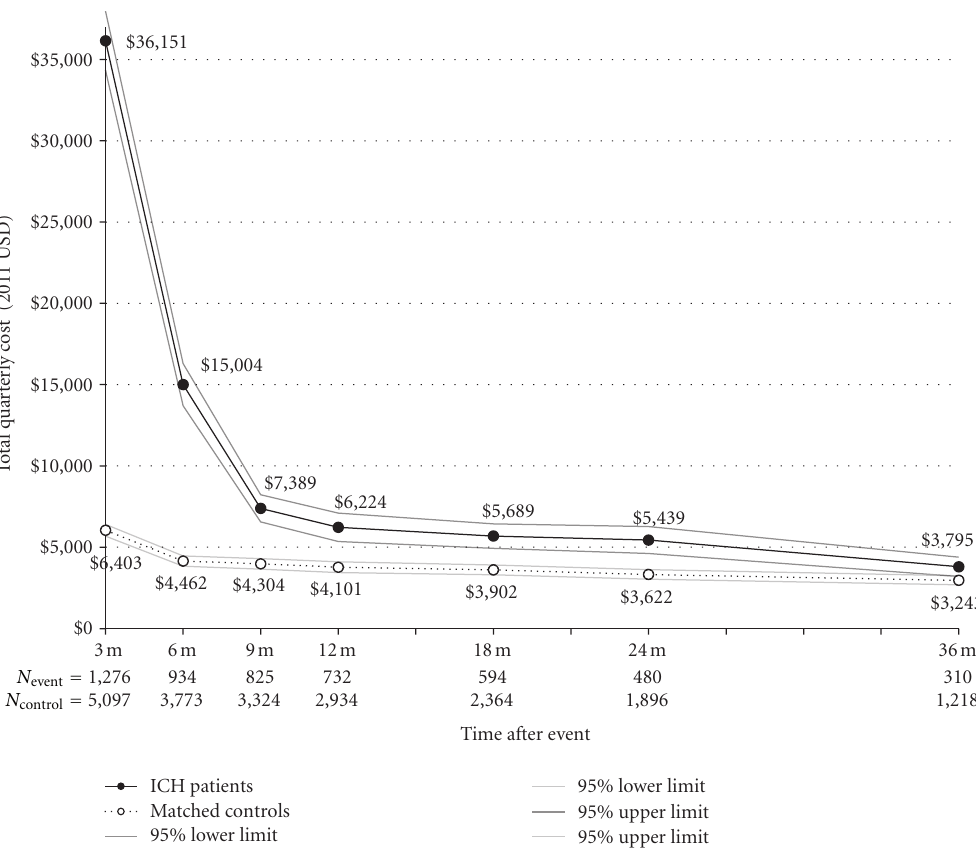
ischemic stroke for 544 (42.1%) patients, ICH for 60 (4.6%) patients, and other major bleeding for 461 (35.7%)